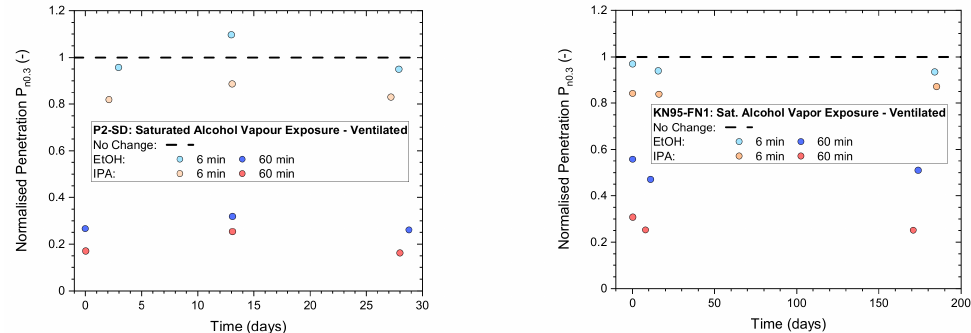
Figure 5. Normalized penetration P n0.3 from flat-sheet screening tests of a P2-rated mask ( left : Shanghai Da Sheng, P2-SD) and a KN95-rated mask ( right : Fujian Nuomigao, KN-95-FN1) exposed to saturated alcohol vapor at low (6 min) and medium (60 min) levels after ventilation for 30 min in a fume hood and then testing after storage in plastic bags for up to 200